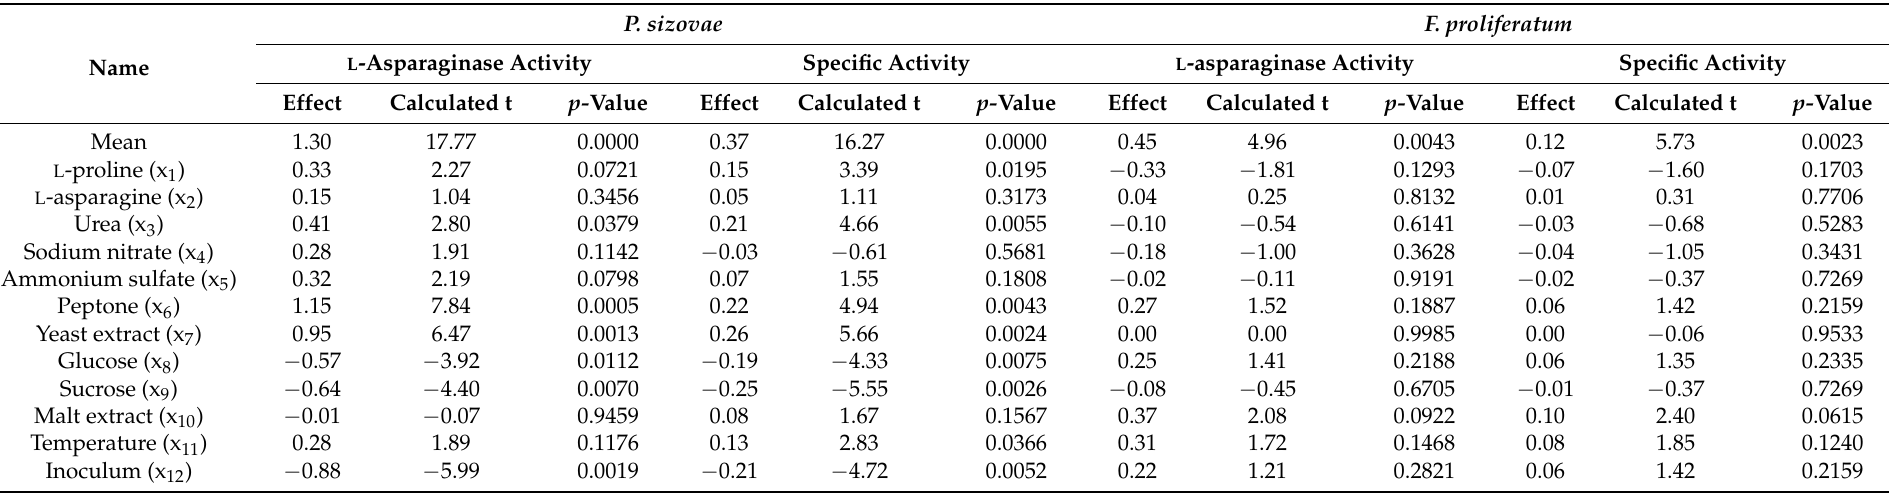
Table 4. Effects and significance of variables for L -asparaginase activity and specific enzyme activity by P. sizovae and F. proliferatum from the results of Plackett–Burman experimental